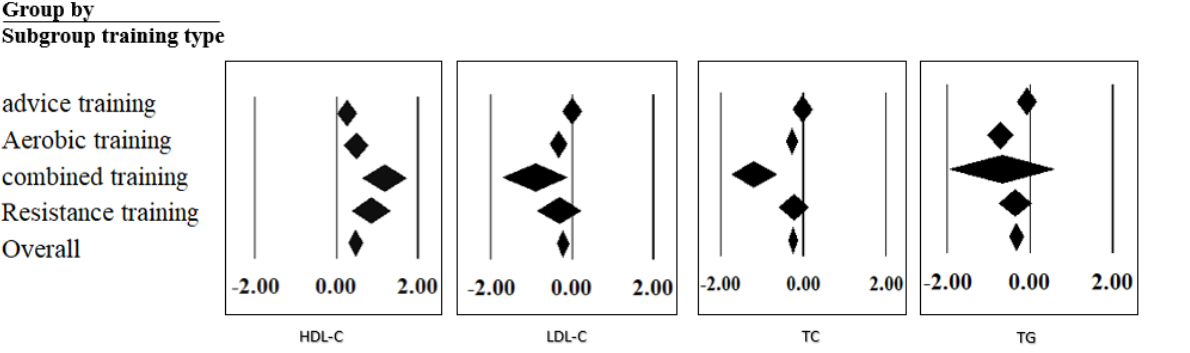
Figure 6. Effects of different training methods on HDL-C, LDL-C, TG, and TC Levels (mg/dL). Forest plot demonstrates mean differences